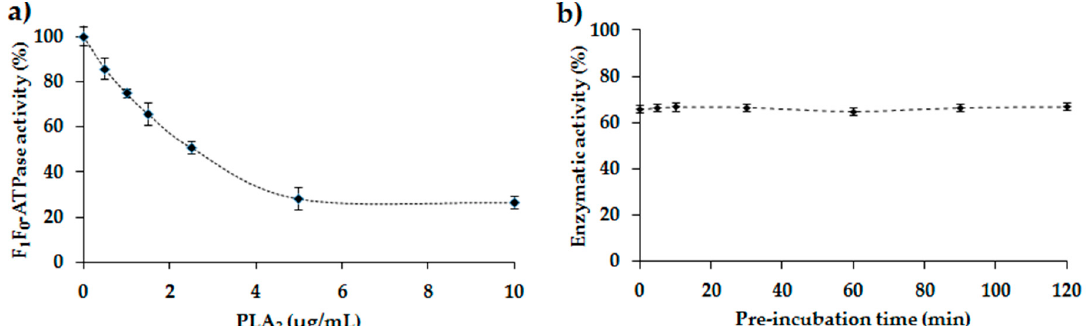
Figure 4. ( a ) Curve showing the effect of different concentrations of PLA 2 on the membrane-bound E. coli F 1 F 0 -ATPase. Error bars show the standard deviation obtained from experiments done in triplicate. Incubation time: 10 min; ( b ) Graph showing the activity of membrane-bound E. coli F 1 F 0 - ATPase as a function of different pre-incubation times of the enzyme in presence of the PLA 2 before the addition of ATP. (ATP) = 100 μ M. (PLA 2 ) = 1.5 μ g/mL. Error bars show the standard deviation obtained from experiments done in triplicate.